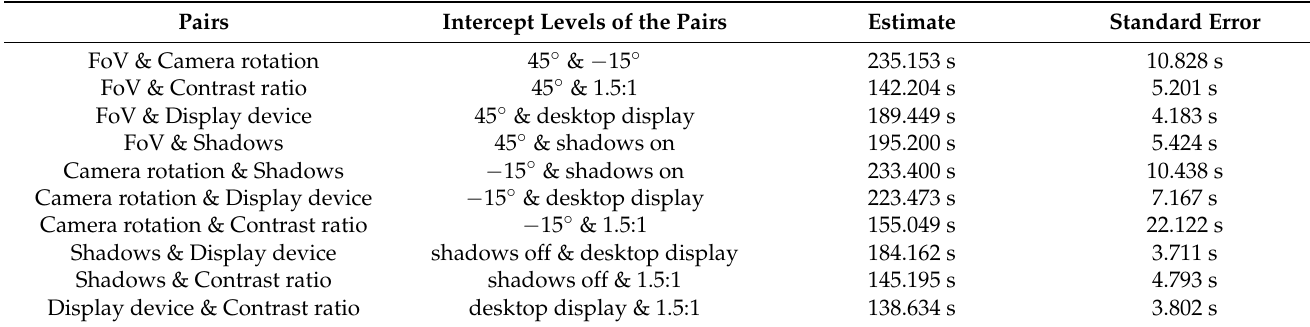
Table 1. The investigated pairs, their intercept values, estimates, and standard